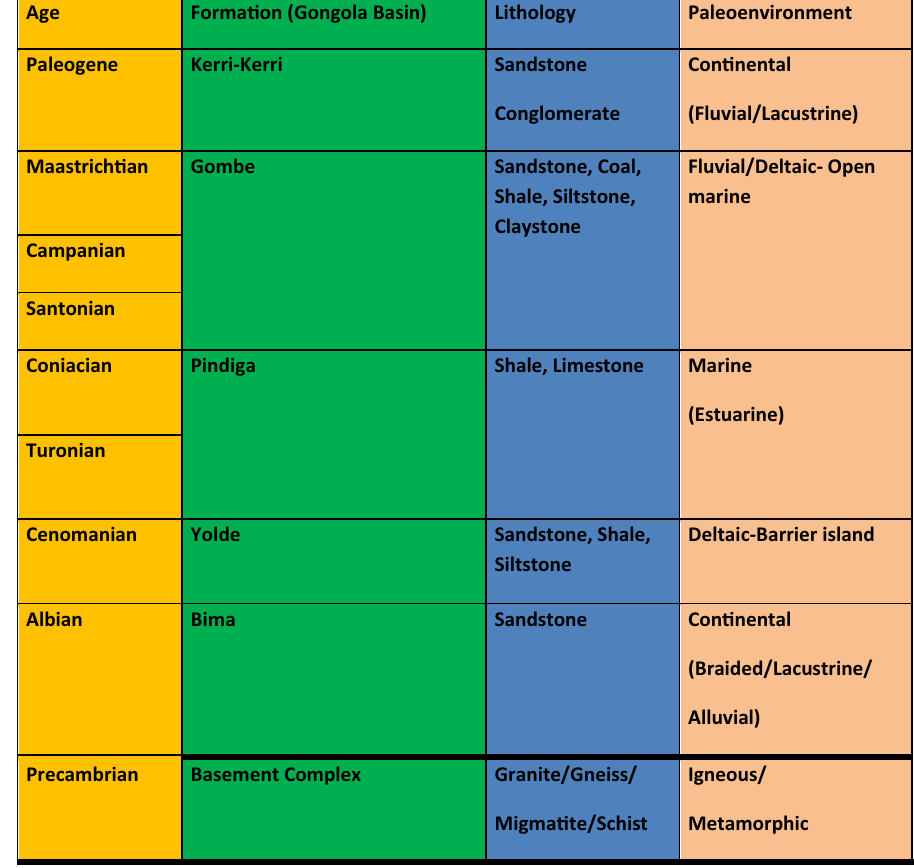
Fig. 3 Stratigraphy of northern Benue Trough. Modified after Abubakar et al.